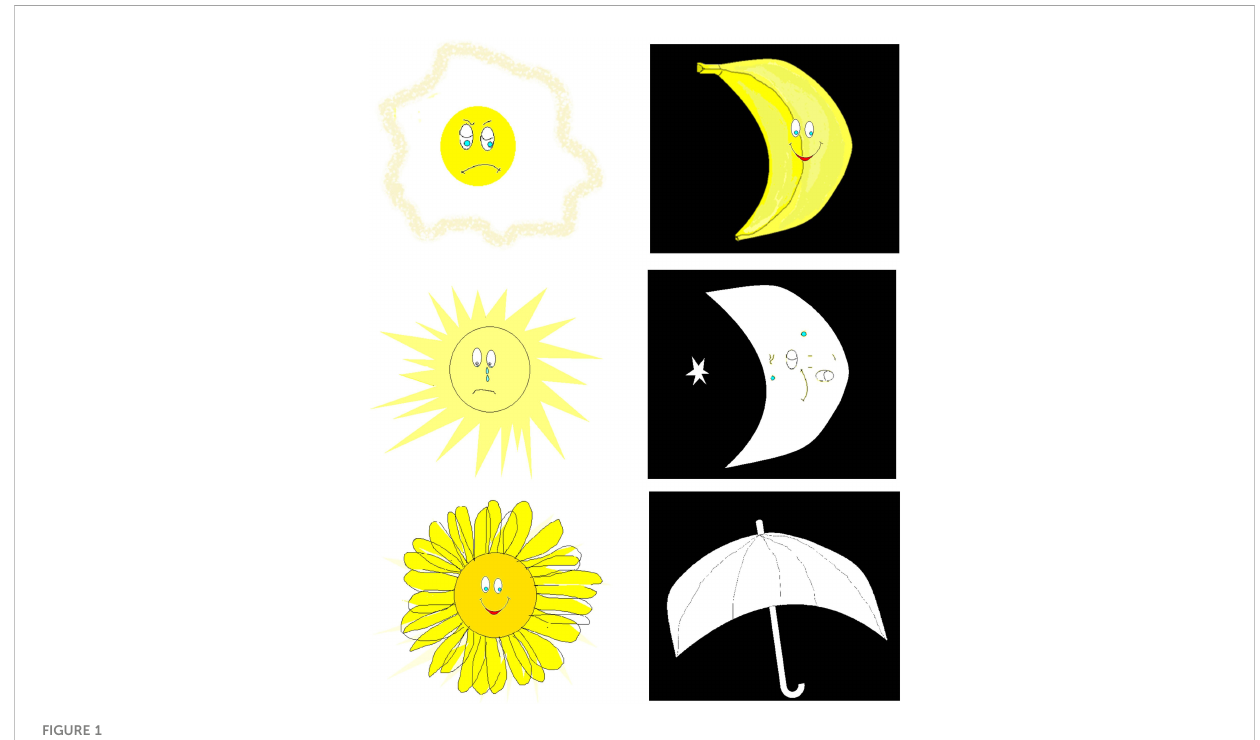
FIGURE 1 Day – night emotional Stroop